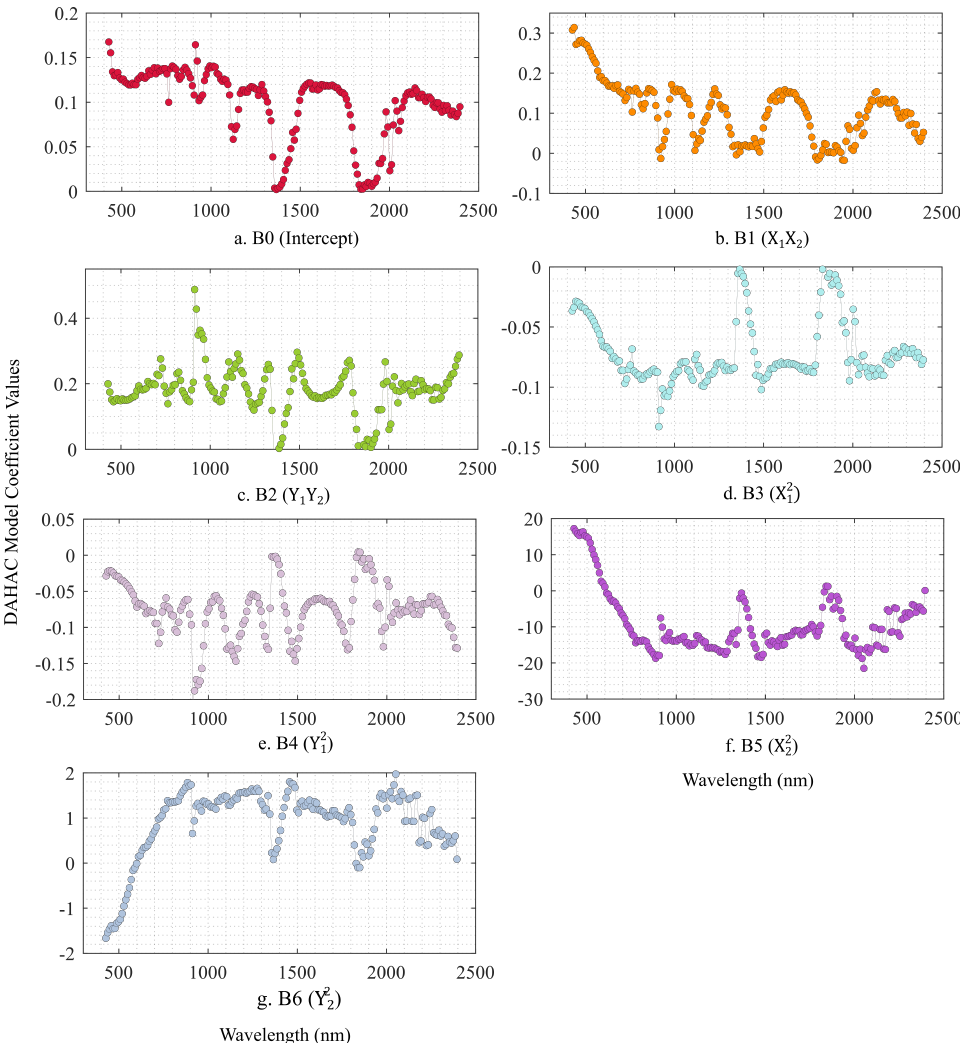
Figure 18. DAHAC model coefficients values for 196 hyperspectral bands. The validation of the DAHAC model (7 coefficients) with the four-angle hyperspectral BRDF model (15 coefficients) for all hyperspectral bands is shown in Figure 19a. It can be observed that the plot shows a linear behavior, which means the DAHAC model statistically agrees with the four-angle hyperspectral BRDF model with a slope equal to one and a bias close to zero. Figure 19b shows the TOA reflectance differences between the two models, and the mean absolute error (MAE) calculated using Equation (13) was found to be close to zero.